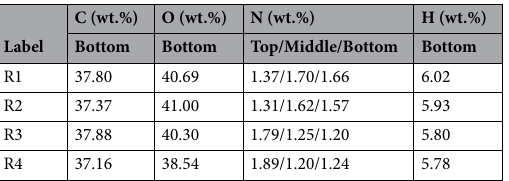
Table 4. Elemental analysis [carbon (C), oxygen (O), nitrogen (N), and hydrogen (H)] of the culms.